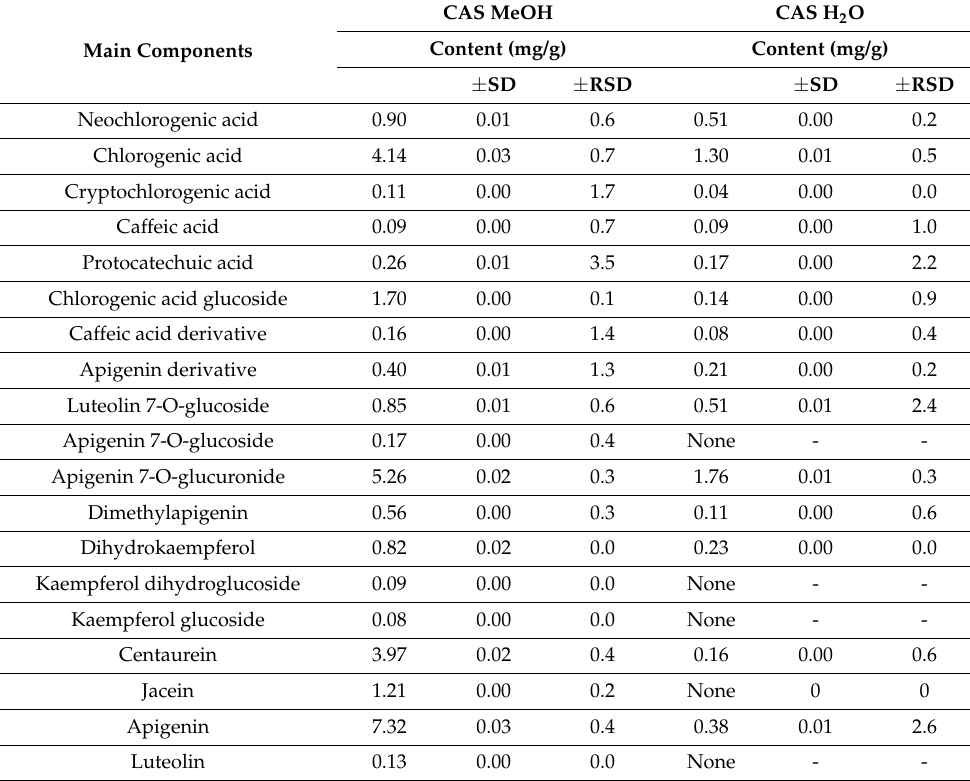
Table 1. Identification and quantification (mg/g dry weight (d.w.)) of contents of main components of tested CAS MeOH and CAS H 2 O C. castriferrei extracts by RP-HPLC/DAD analysis.